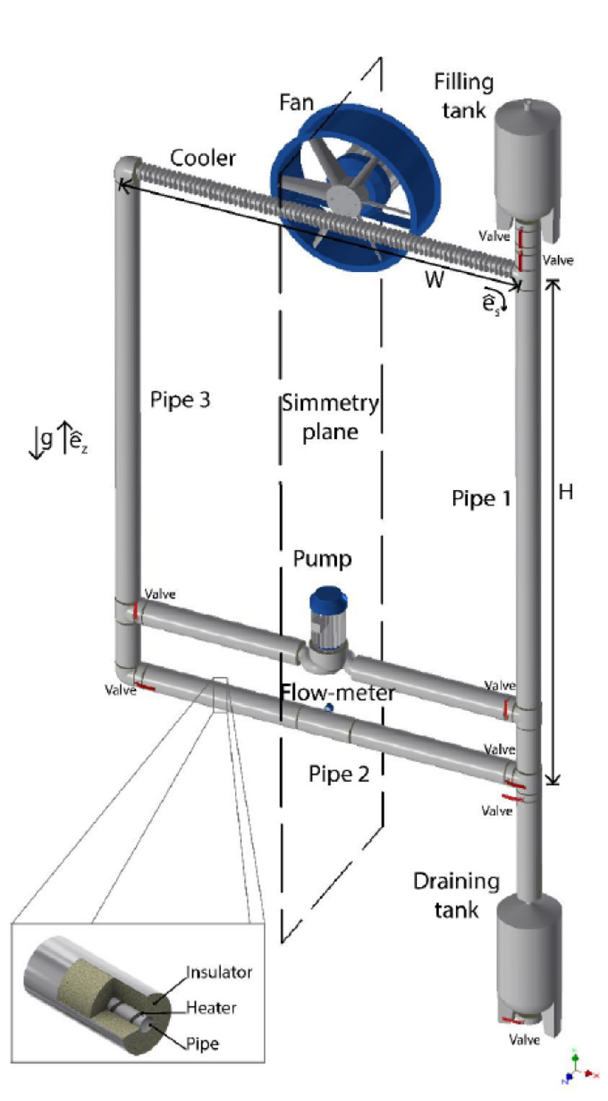
Fig. 2. Schematic view of DYNASTY.